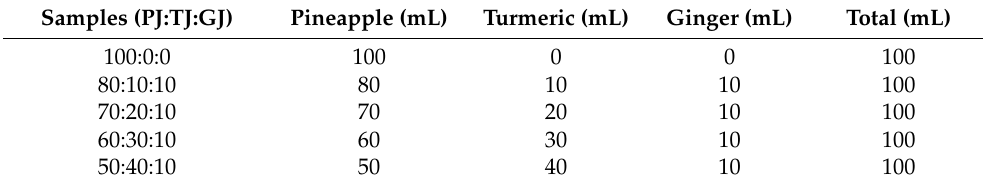
Table 1. Formulation of Ginger, Pineapple, and Tumeric Juice Mix by